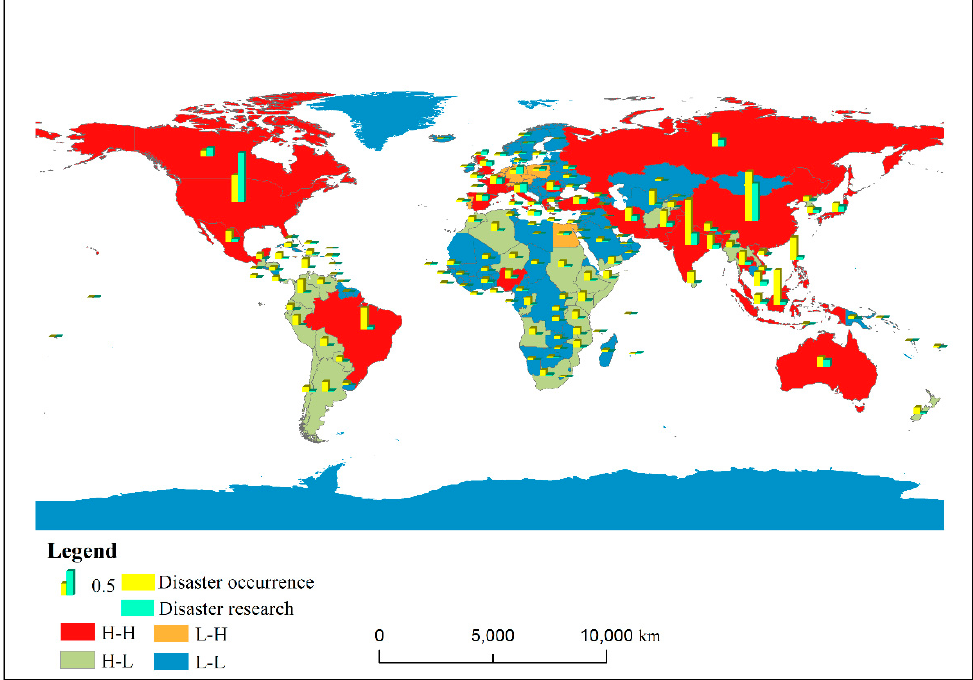
Figure 4. Spatial distribution of flood disaster occurrence and hot research areas.